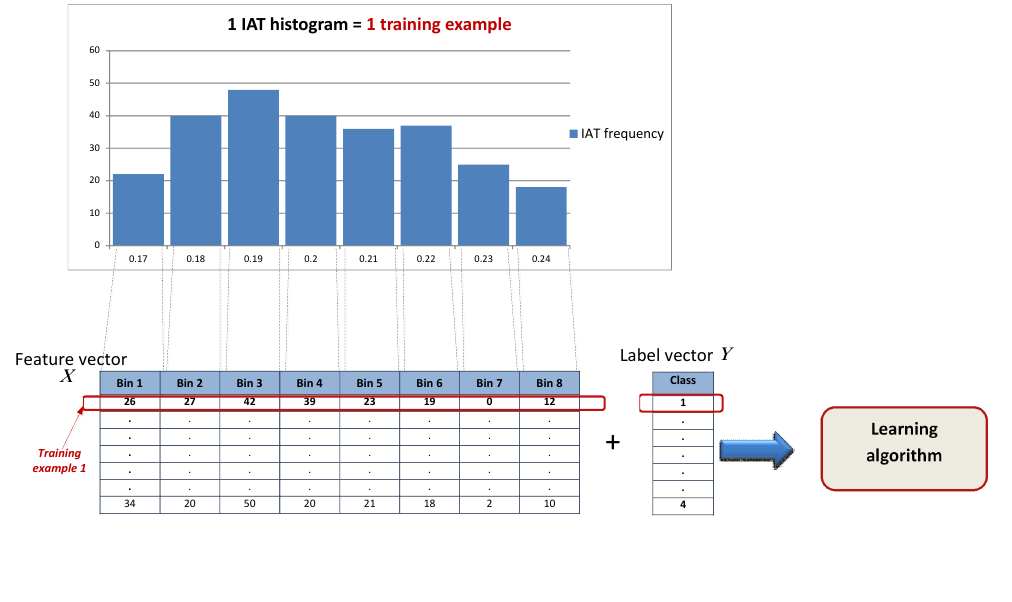
Figure 6. Explanation for training data